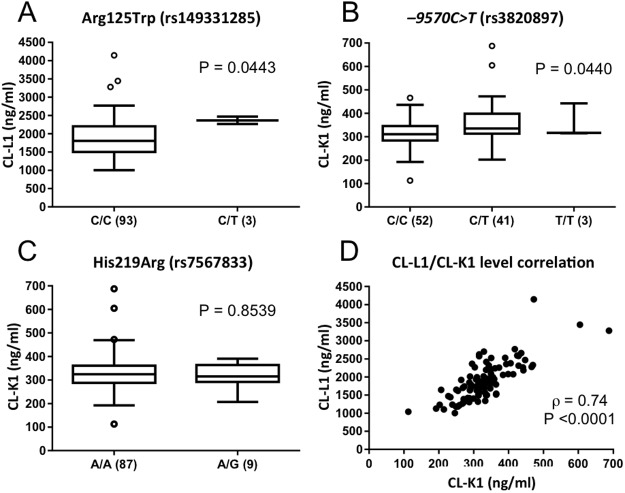
Impact of allelic variants on serum levels.A-C, the serum levels of CL-L1 and CL-K1 and the corresponding genotype. Horizontal bars indicate median values; number in parenthesis, number of individuals and white circles, outliers. Statistical significance was determined by non-parametric Mann-Whitney and Kruskal-Wallis tests. D, the distribution of CL-L1 and CL-K1 levels in the cohort. The strength of the correlation was calculated using Spearman Rank.